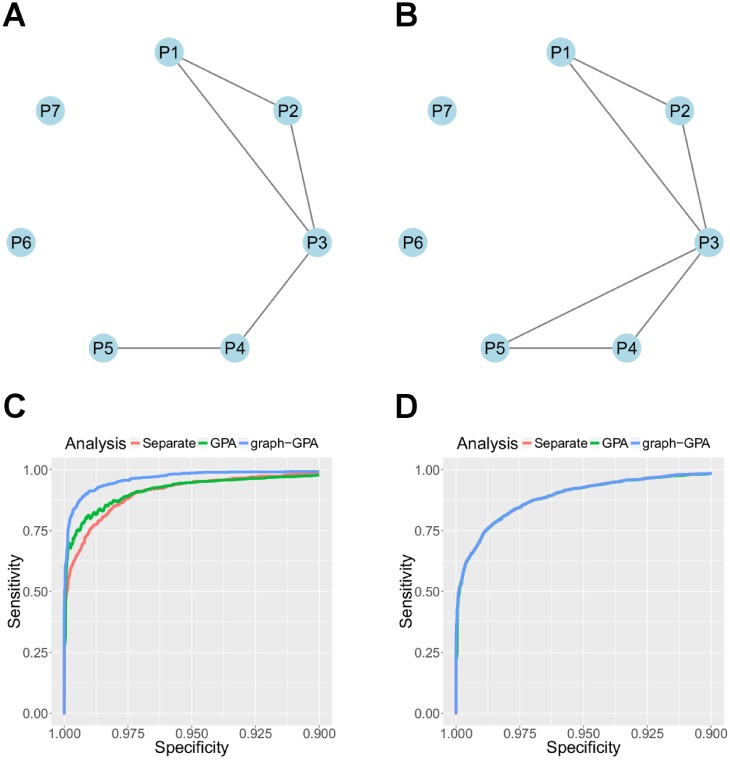
Simulation studies.(a) true phenotype graph, which was accurately recovered by graph-GPA. (b) phenotype graph estimated by GPA, which added an additional edge between P3 and P5. (c, d) receiver operating characteristic (ROC) curves for phenotypes P1 and P7. For a phenotype correlated with other phenotypes, such as P1 (c), joint analyses (graph-GPA and GPA) improve statistical power to identify associated SNPs compared to separate analyses, while graph-GPA further significantly outperforms GPA and separate analyses. In contrast, for independent phenotype such as P7 (d), joint and separate analyses have comparable statistical power in association mapping. Note that in (c) and (d), we show the averaged ROC for GPA, based on the pairs estimated to be correlated with P1 in (b), i.e., P1–P2 and P1–P3.